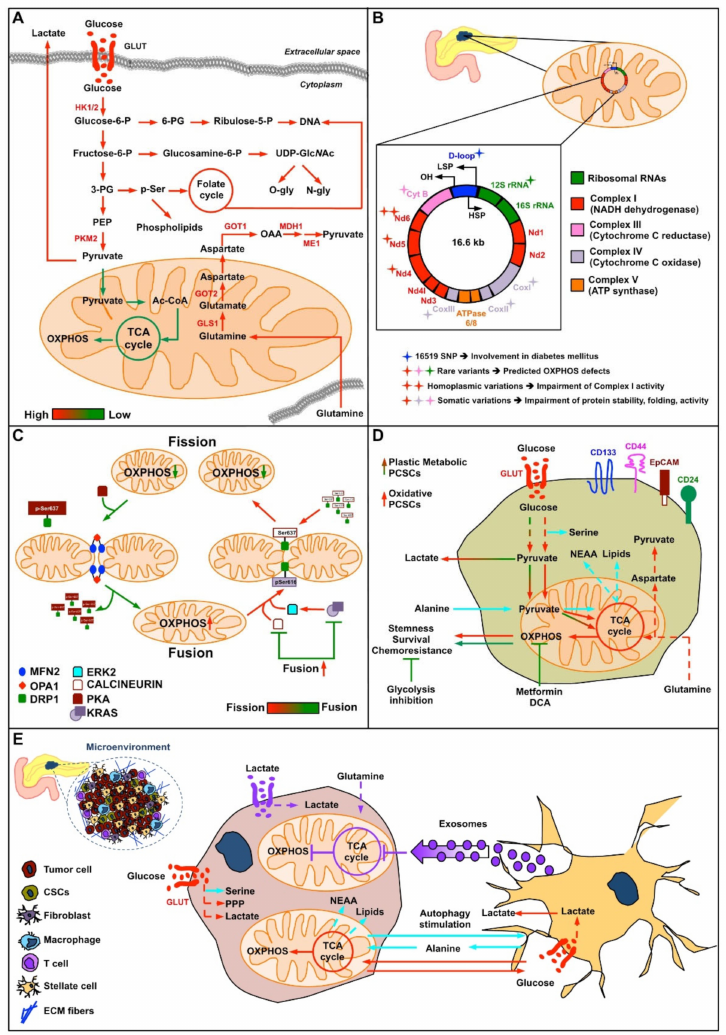
Figure 3. ( A ) Schematic representation of the main metabolic pathways in PC. Red indicates increased protein expression and/or metabolic flux; green indicates decreased metabolic flux. ( B ) Schematic representation of mtDNA and main mutations identified in PC. LSP and HSP arrows designate the promoter and direction of the H-strand (HSP) and L-strand (LSP), respectively. Colors refer to specific mtDNA-encoded OXPHOS subunits. Red: complex I subunits. Pink: complex III subunits. Purple: complex IV subunits. Orange: complex V subunits. Blue: D-loop region. Green: ribosomal RNAs. The colored stars indicate the mutations found or predicted in PC mtDNA. ( C ) Schematic representation of the mitochondrial fusion and fission cycle and some of the proteins involved in the regulation of this cycle. ( D ) Schematic representation of PCSC metabolism and some stemness markers. Red refers to an increased effect, green refers to a reduced effect, and green/red represents PCSC metabolic plasticity (for detailed information, refer to the main text). ( E ) Schematic representation of tumor cell composition and the identification of the main metabolic cross-talk connections identified between cancer cells (left) and stellate cells (right). The different colors (red, cyan, and purple) indicate the three cross-talk connections described in the main